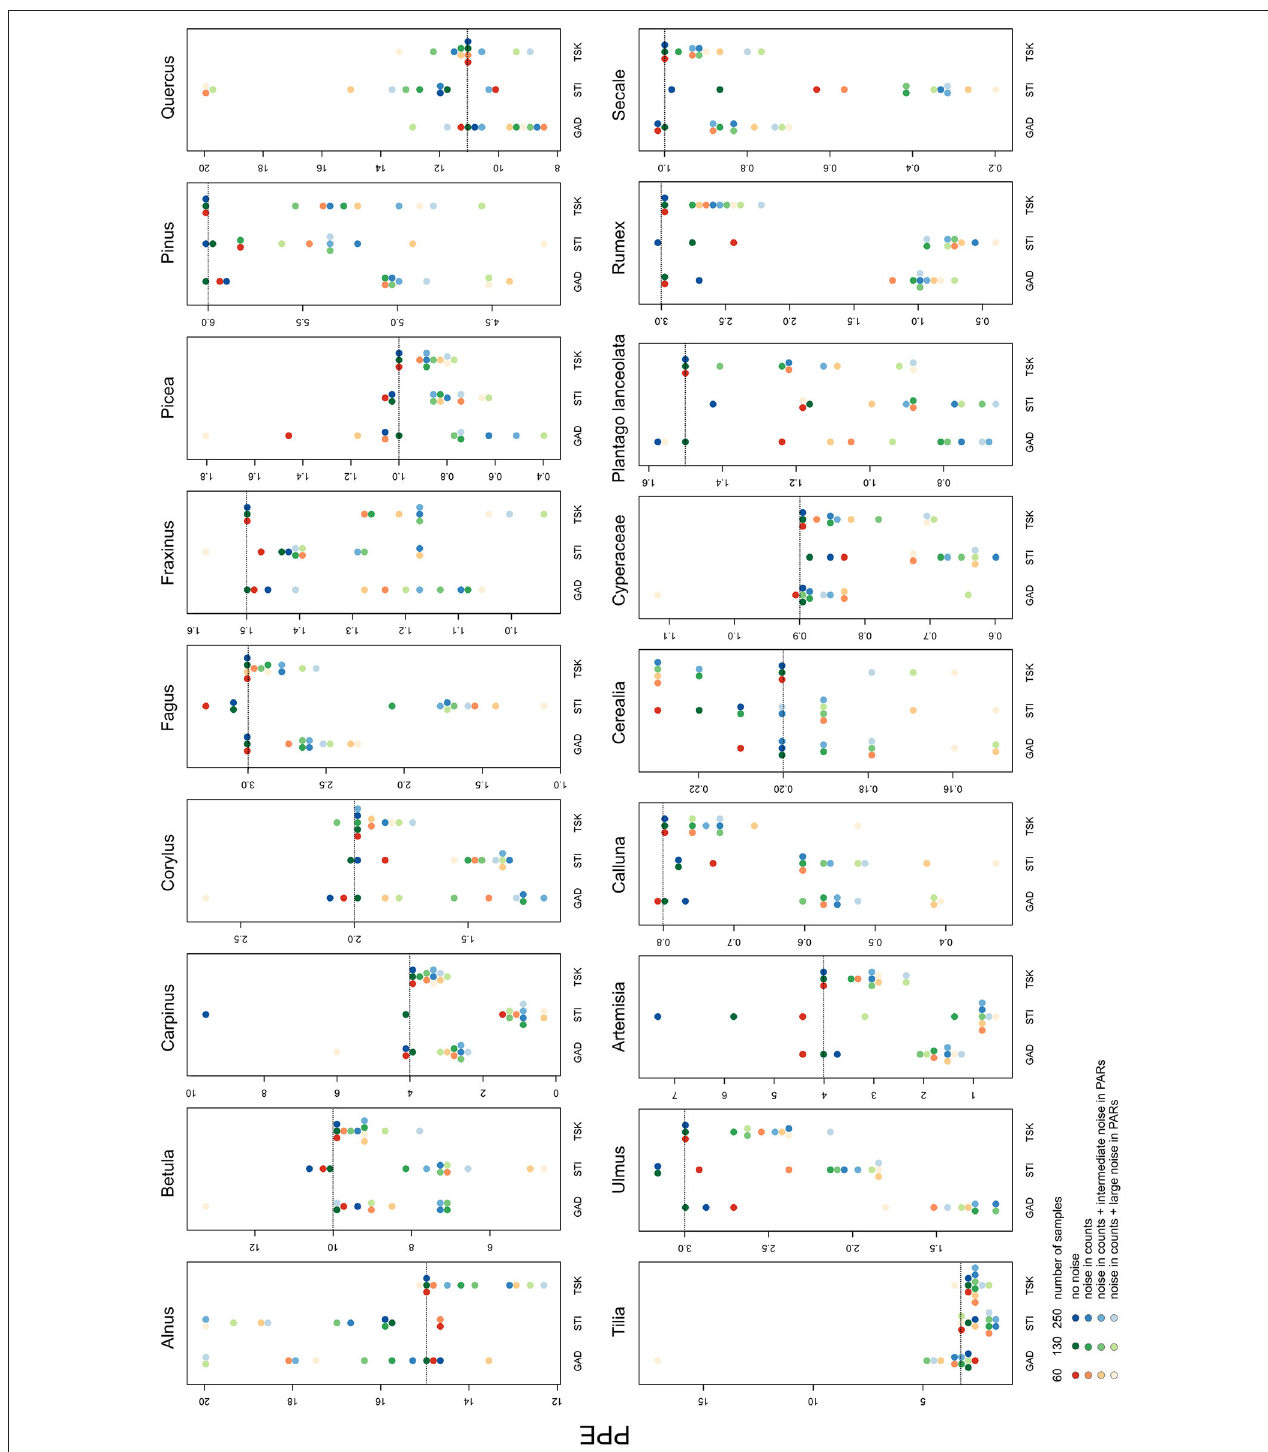
FIGURE 4 | Median of PPEs produced in each of the 36 experiments. The colors represent the sample size, shades represent the noise added in the pollen data. Dotted lines show original pollen productivity of each taxon. Note the scaling of the y-axes. For full results see Supplementary Material.